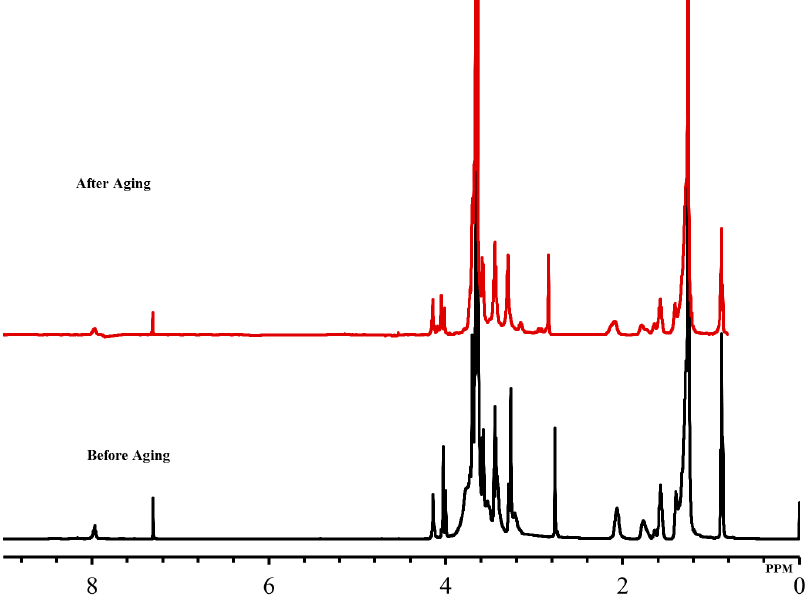
Figure 7. 1 H NMR of GS10 sample before aging and after aging.